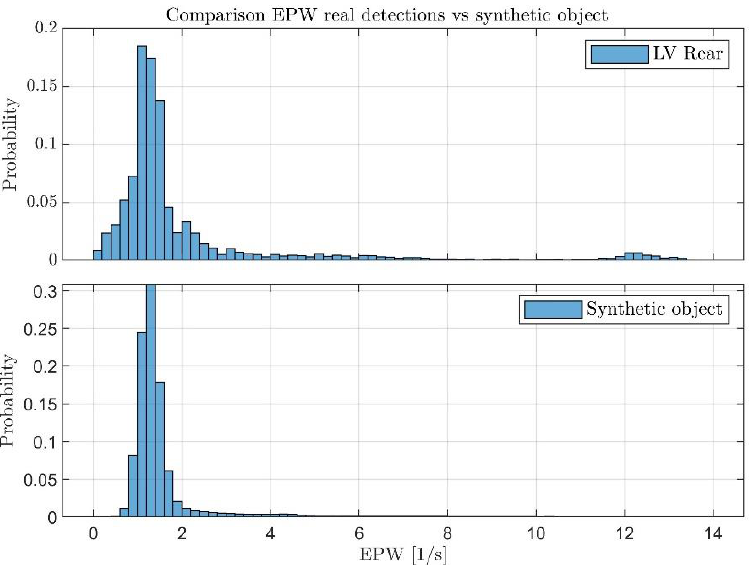
Figure A4. Histograms showing the probability distributions of the EPW values for the rear part of the real LV (up) and the synthetic object (down). The mean and standard deviation as obtained after rendering the scene for the synthetic object are adjusted to resemble those of the LV.